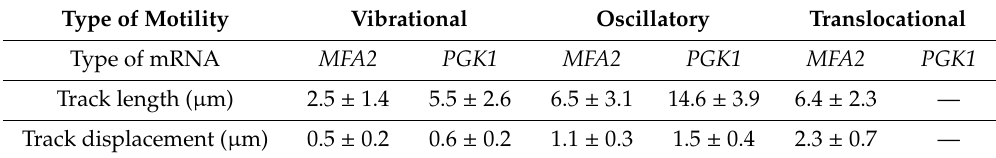
Table 1. Range of motion parameters for MFA2 and PGK1 granules tracked in 3D. Type of